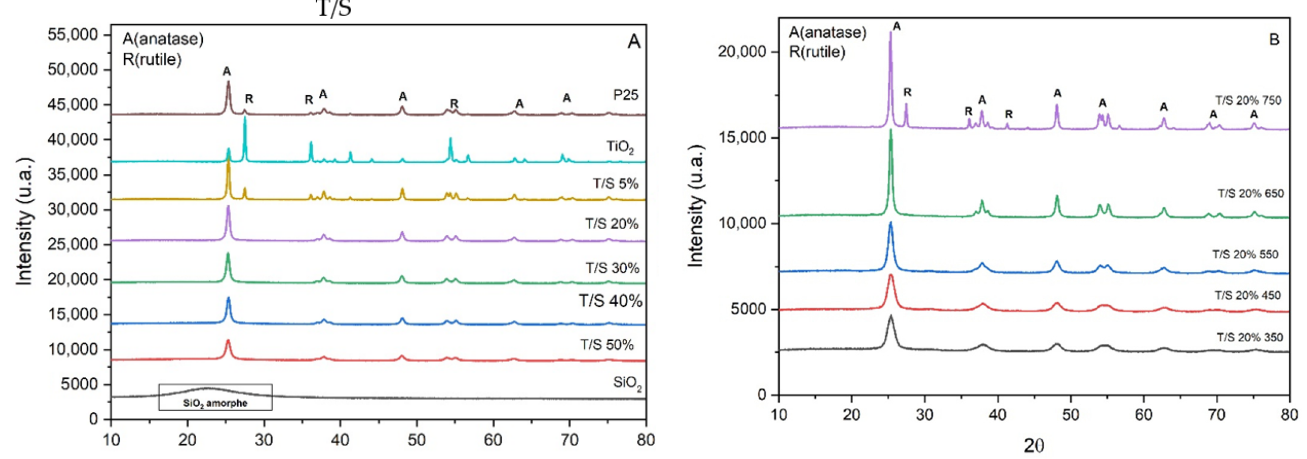
Figure 2. X-ray diffractogram of samples ( A ): SiO 2 , T/S–X at 650 ◦ C ( B ): TS 20%–T.